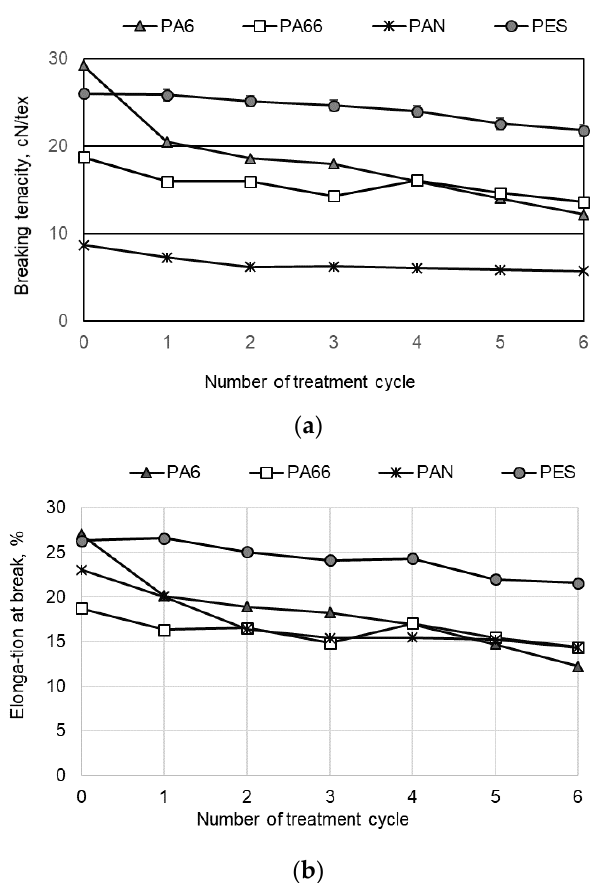
Figure 6. Influence of the number of the treatment cycle on the ( a ) breaking tenacity and ( b ) the elongation at break of investigated synthetic fibers.